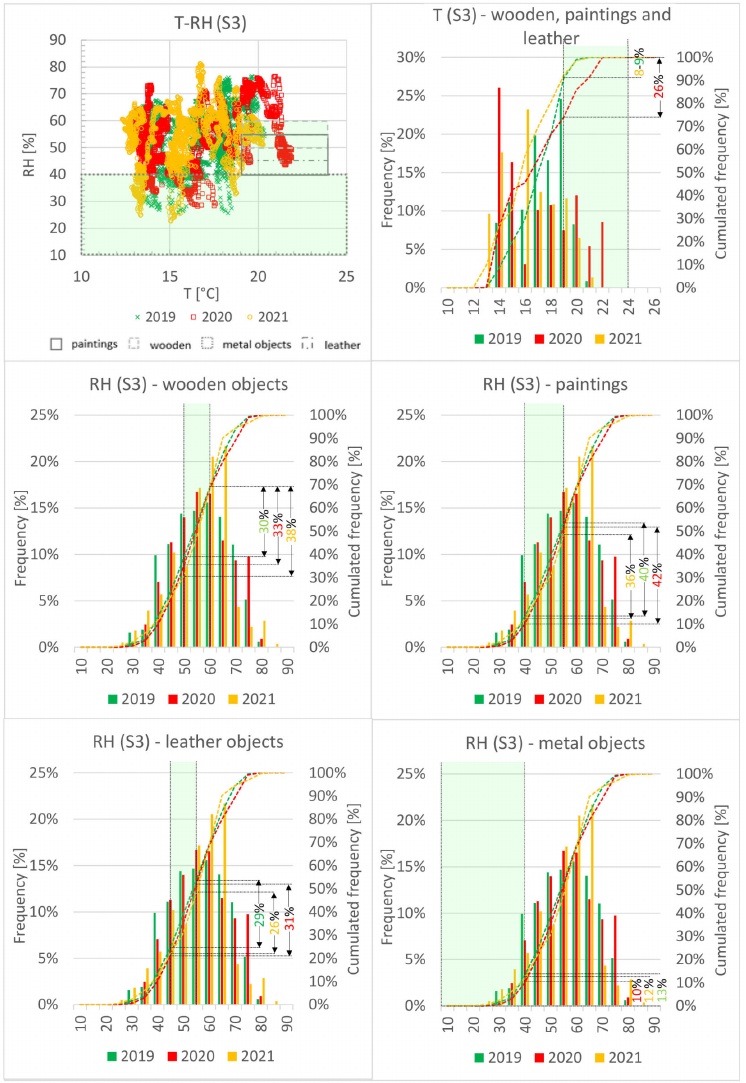
Figure 12. Scatterplot and frequency distribution comparison of indoor climate data (datalogger S3) from March to May 2019, 2020 and 2021 with respect to the conservation range (the green area) proposed by UNI10829 for different